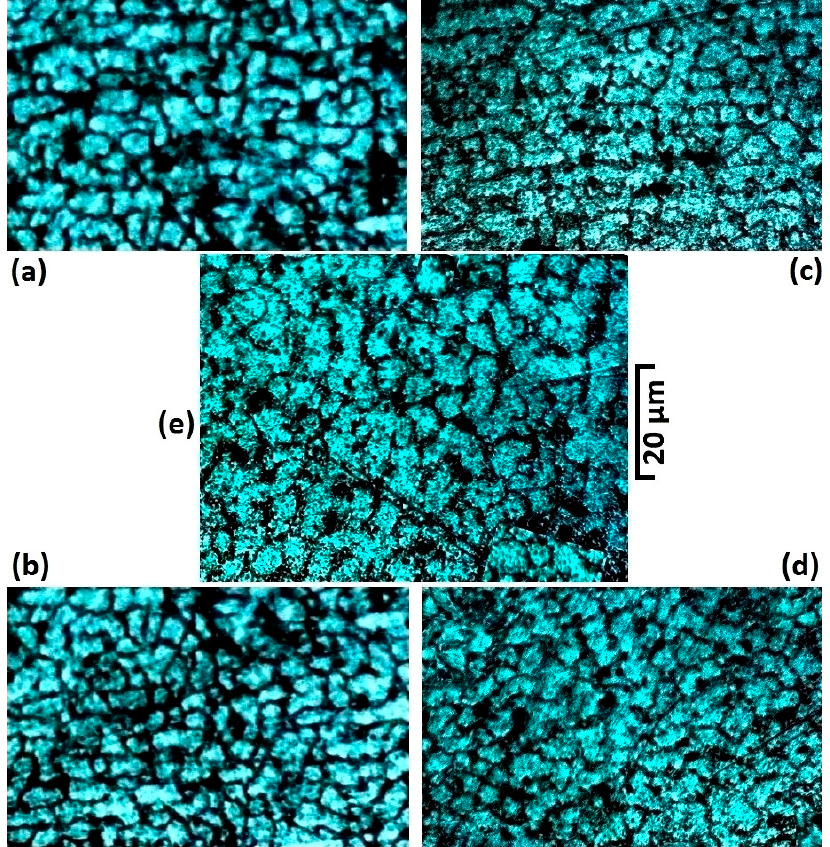
Figure 9. Equiaxed polycrystalline microstructure in different areas of the S.Z, ( a ) top shoulder-A.S; ( b ) bottom shoulder-A.S; ( c ) top shoulder-R.S; ( d ) bottom shoulder-R.S; and ( e ) middle of S.Z (all processed by etchant G). The average grain size in the S.Z is smaller than 10 µ m, but in the centre of the S.Z the grains are